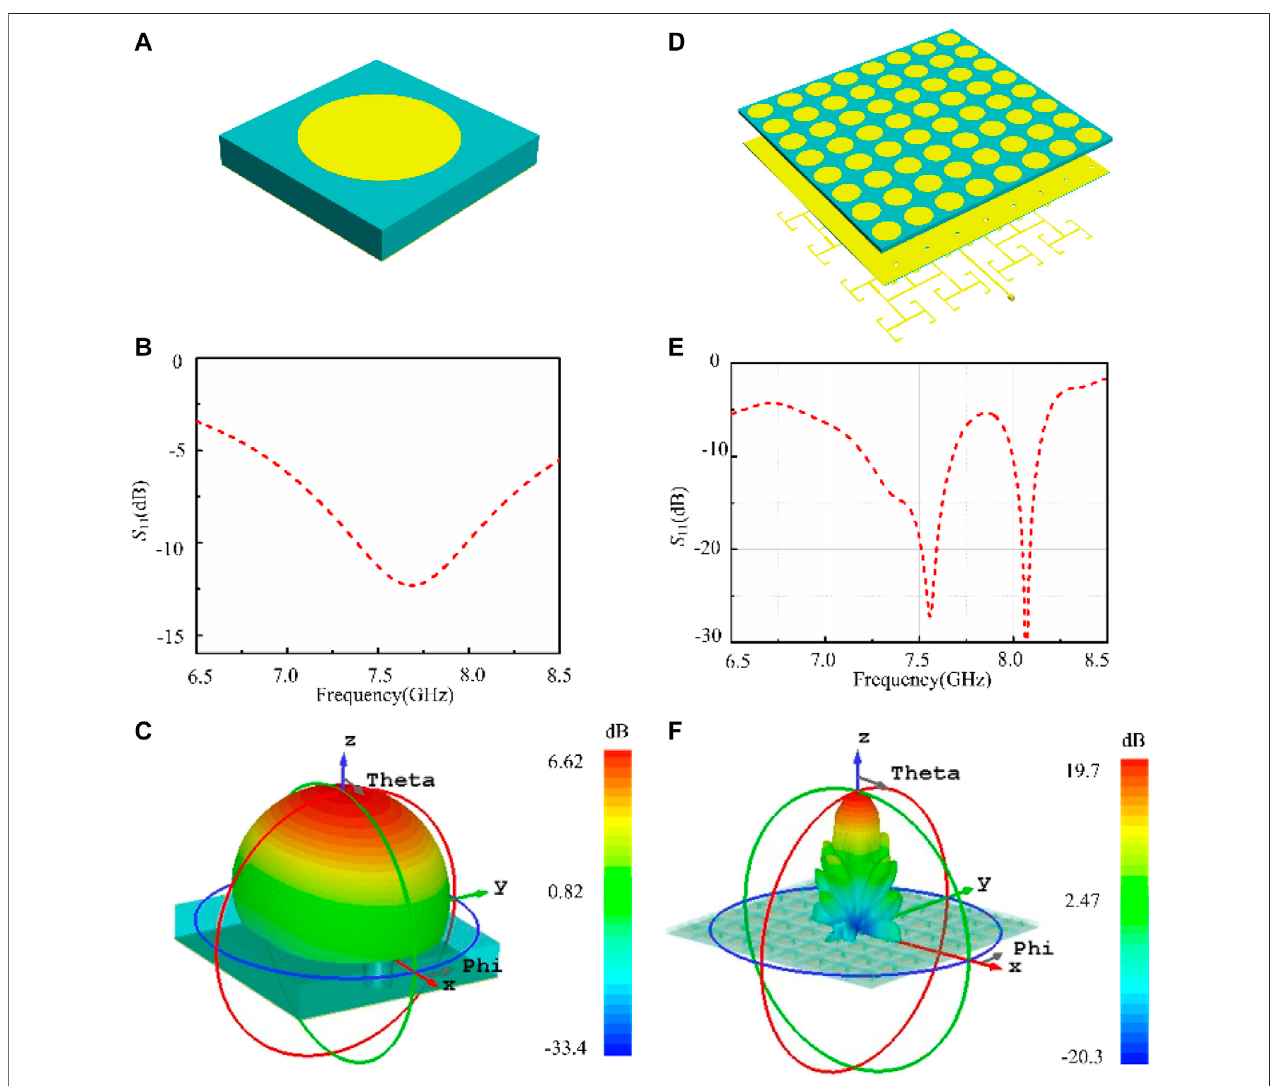
FIGURE 3 | (A) Con fi guration of the antenna. (B) S 11 of the antenna. (C) 3-D radiation patterns of the circular patch at 7.3 GHz. (D) Con fi guration of the antenna array. (E) S 11 of the antenna array. (F) 3-D radiation patterns of the antenna array at 7.3